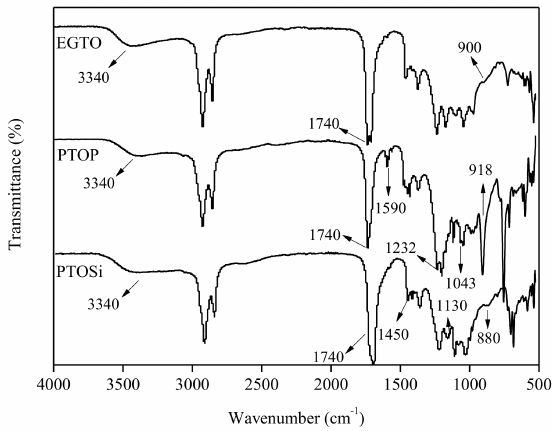
Figure 2. Fourier transfer infrared (FTIR) spectra of EGTO, PTOP, and PTOSi.